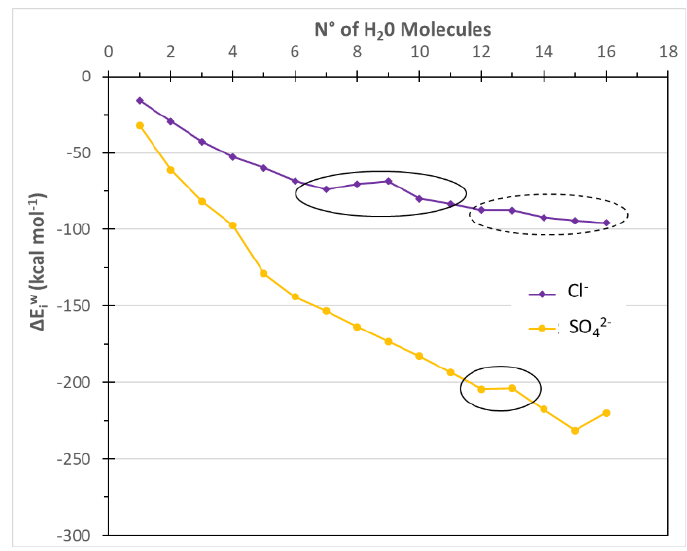
Figure 3. ΔE iw for the anions as function of the hydration level. Solid circles indicate the ΔE iw plateaus referred to the first hydration shell, while the dashed circle indicates the formation of the second hydration shell.